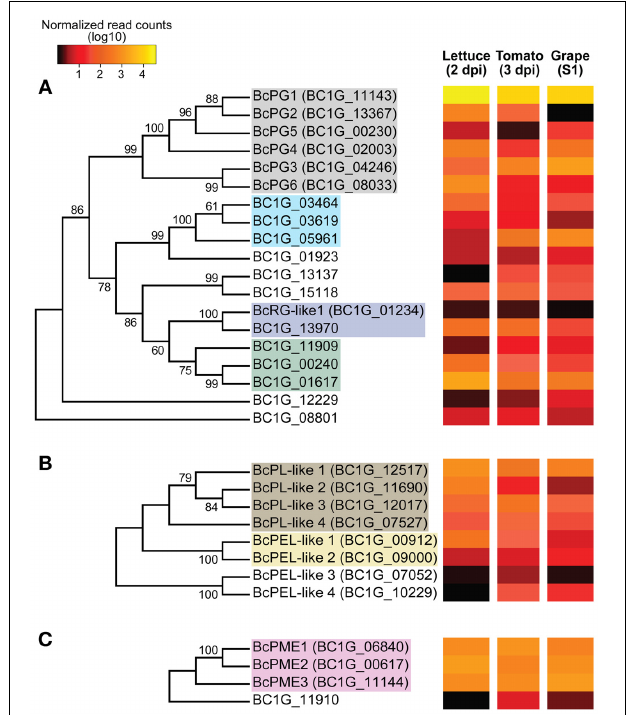
FIGURE 4 | Phylogenetic tree and expression levels of characterized and candidate enzymes that act on pectin backbones. Bootstrap consensus trees inferred from 1000 replicates using the Neighbor-Joining method for the Botrytis CAZymes with predicted signal peptides in the GH28 (A) , PL1 and PL3 (B) and CE8 (C) subfamilies. The percentages ( > 50%) of replicated trees in which the associated taxa clustered together in the bootstrap test are shown next to the branches. Colored-boxes in the phylogenetic trees indicate protein tribes ( > 2 members) determined by BLASTp alignments ( e -value < 1e − 6) and Tribe-MCL (Enright et al., 2002). Boxes in (A) , gray = tribe 1, light blue = tribe 16, purple = tribe 26 and green = tribe 10. Boxes in (B) brown = tribe 8, yellow = tribe 24. In (C) , pink box = tribe 11 (Supplemental Table S2). The colors in the heat maps represent the numbers of DESeq-normalized transcript counts (log10) of the Botrytis genes in infected lettuce leaves, ripe tomato fruit and grape berries.